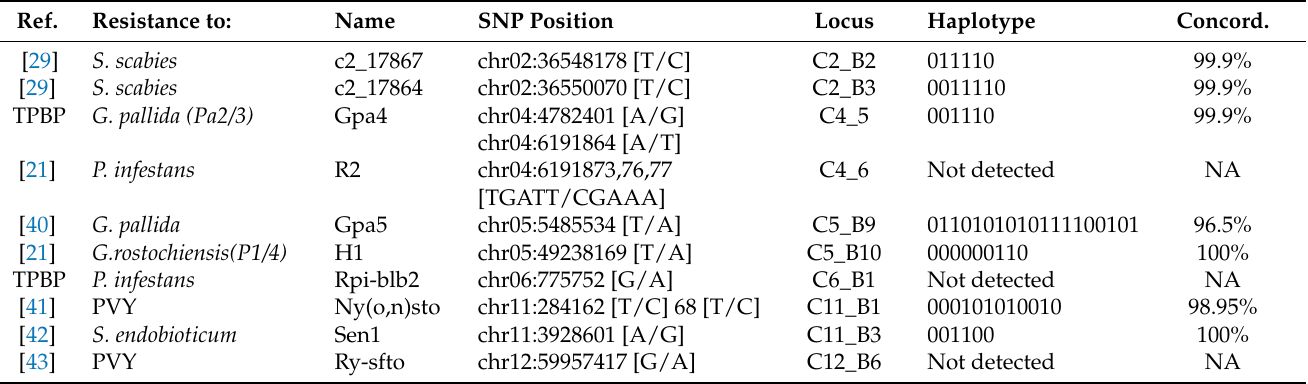
Table 2. Multiallelic haplotypes linked to disease resistance markers: Ref. = Literature refer- ence/Developed by Teagasc Potato Breeding Program(TPBP); Locus = Name of the locus containing the marker in PotatoMASH; Haplotype = haplotype containing target SNP; Concord. = % concordance between marker dosage and haplotype dosage.